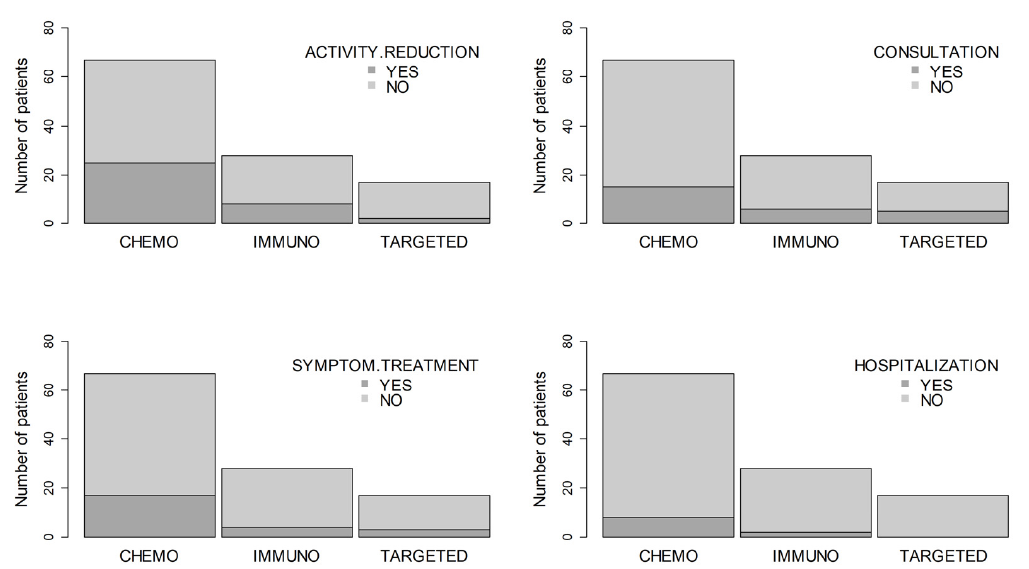
Figure 2. Relationship between the type of treatment and the severity of symptoms. No statistically significant associations were found according to Fisher’s exact test [9] (sig. level = 0.05).